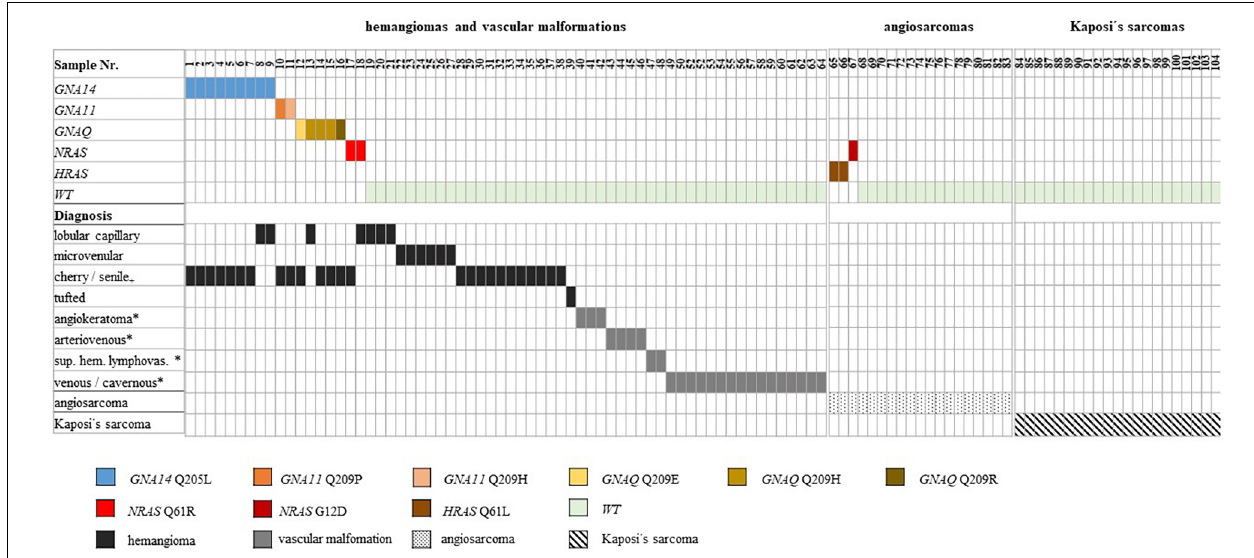
FIGURE 1 | Distribution of activating mutations identified in vascular tumors. Distribution of activating mutations identified in different oncogenes in the vascular tumor cohort. The resulting amino acid changes are color-coded according to the scheme underneath the illustration [ + not listed as an independent entity according to ISSVA (2018), * classified as malformations according to ISSVA, sup. hem. lymphovas. = superficial hemosiderotic lymphovascular (previously referred to as targetoid